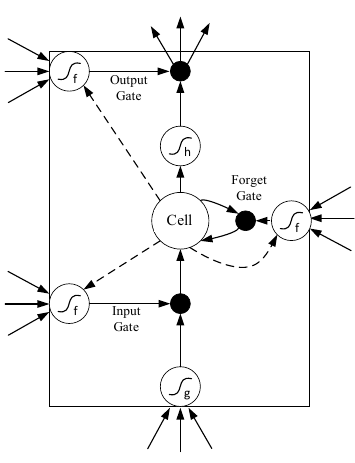
Figure 5. Long Short-Term Memory (LSTM) structure.